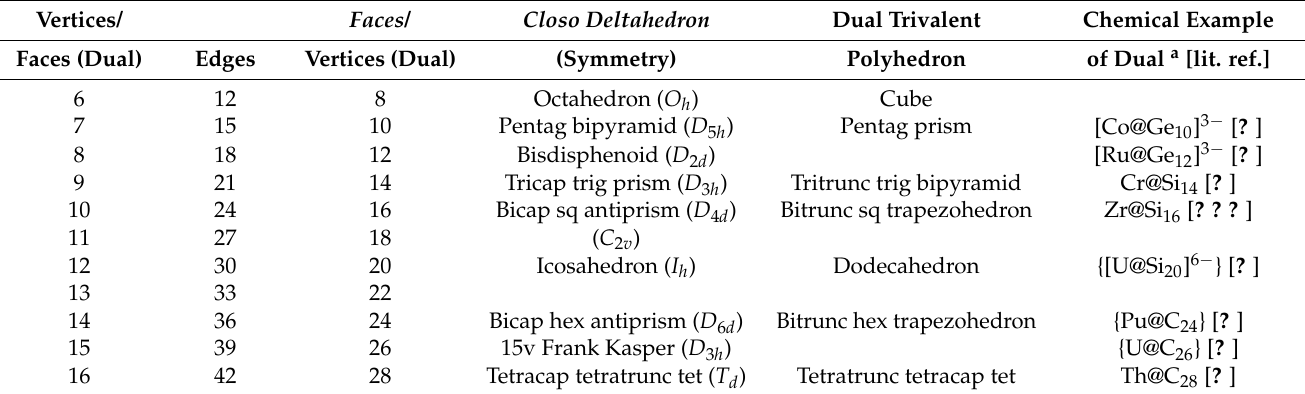
Table 1. The most spherical closo deltahedra and their duals.